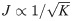
Correlations from theory and simulations for a two-population binary network with asymmetric connectivity.
A Average pairwise cross-covariances from simulations (solid curves) and Eq (55) (dashed curves). B Naive scaling with J ∝ 1/K but without adjustment of the external drive changes the correlation structure. C With an appropriate adjustment of the external drive (σ
ex = 53.4, σ
ix = 17.7), scaling synaptic weights as J ∝ 1/K is able to preserve correlation structure as long as N and K are reduced by comparable factors. D The same holds for J∝1/K (μ
ex = 43.3, μ
ix = 34.6, σ
ex = 46.2, σ
ix = 15.3), but the susceptibility S is increased by about 20% already for N = 0.75 N
0 in this case. In B, C, and D, results of simulations are shown. The curves in C and D are identical because internal inputs, the standard deviation of the external drive, and the distance to threshold due to the DC component of the drive in D are exactly KK0 times those in C. Hence, identical realizations of the random numbers for the connectivity and the Gaussian external drive cause the total inputs to the neurons to exceed the threshold at exactly the same points in time in the two simulations. The simulated time is 30 s, and the population activity is sampled at a resolution of 0.3 ms.